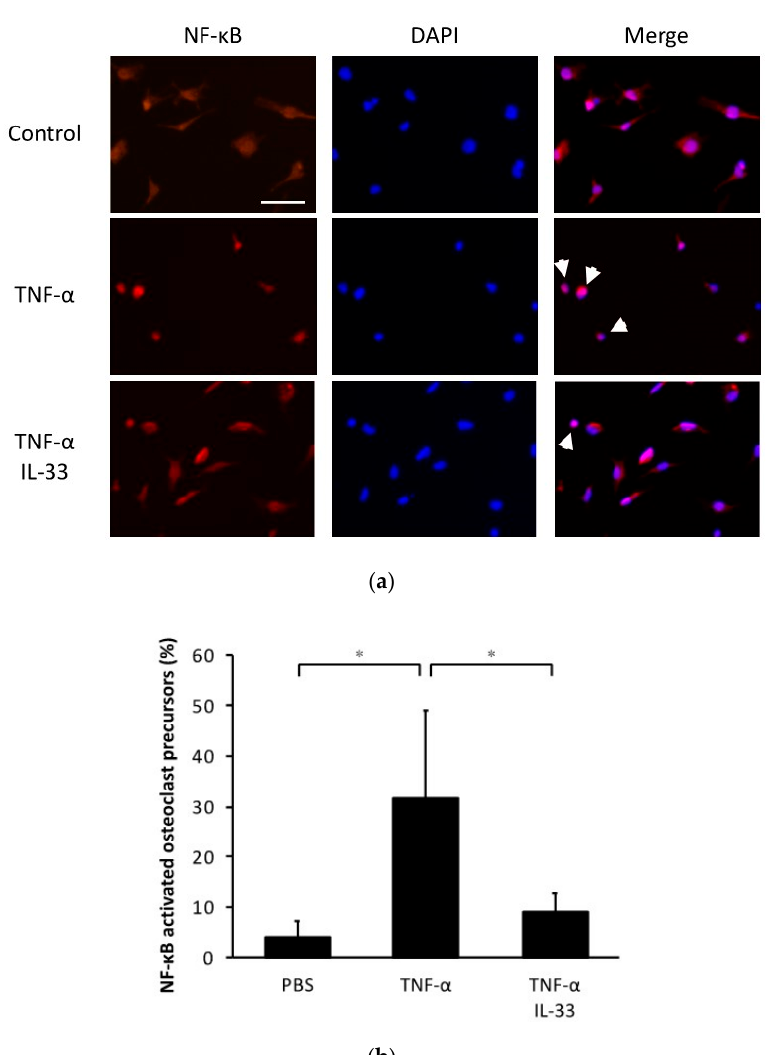
Figure 5. IL-33 inhibited NF- κ B activation by TNF- α in osteoclast precursors. ( a ) Representative fluorescent images of osteoclast precursors cultured with TNF- α or TNF- α + IL-33 after 1 h. Cells were stained for NF- κ B p65 antibody and Alexa Fluor 555. 4 ′ ,6-diamidino-2-phenylindole (DAPI) was used as counterstaining. White arrows indicate NF- κ B activated osteoclast precursors. Scale bars = 50 µm. ( b ) The percentage of NF- κ B activated osteoclast precursors to all osteoclast precursors. Results are expressed as means ± SD. The statistical significance of differences was determined by Scheffe’s test ( n = 4; * p < 0.05).